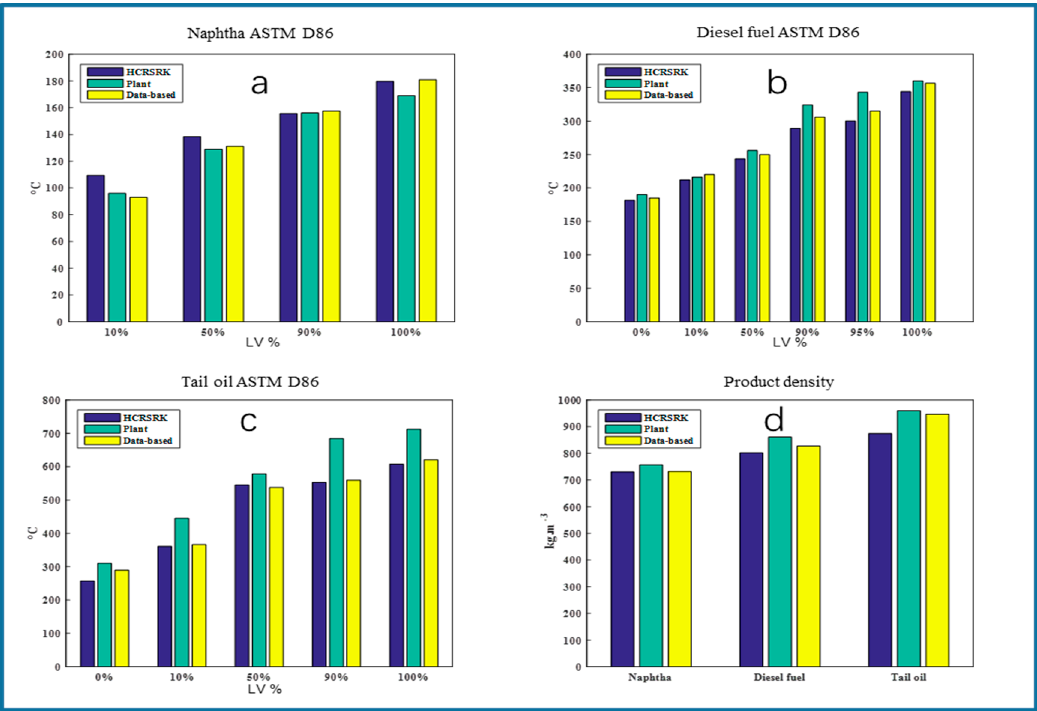
Figure 12. Predictions of the properties of different products with the two methods: ( a ) ASTM D86 distillation curve of naphtha; ( b ) ASTM D86 distillation curve of diesel fuel; ( c ) ASTM D86 distillation curve of tail oil; ( d ) density of three products.